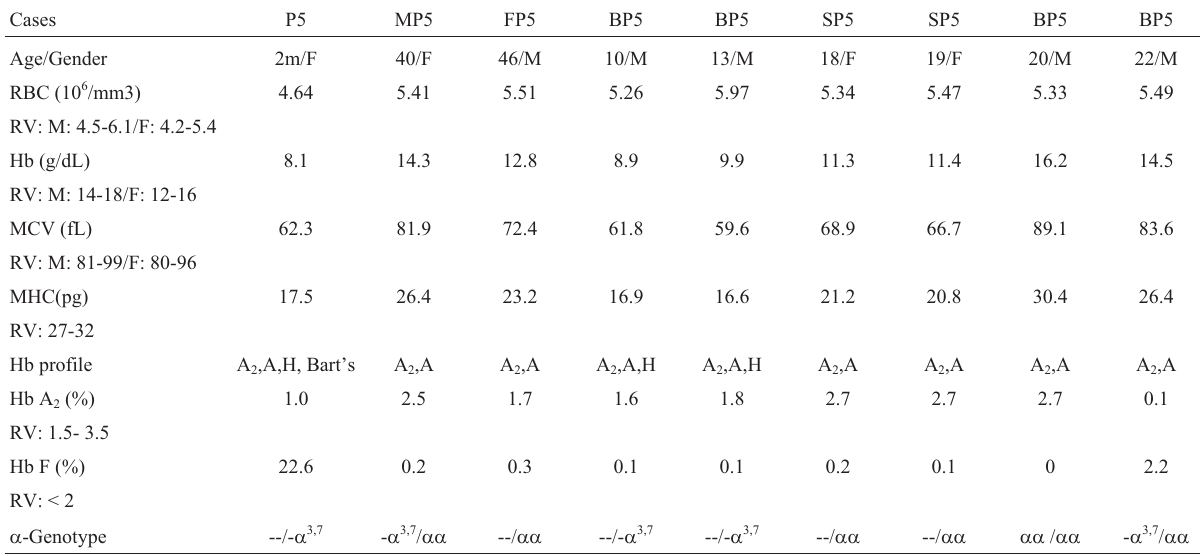
Table 2 - Hematological and molecular data of Patient P5 and her